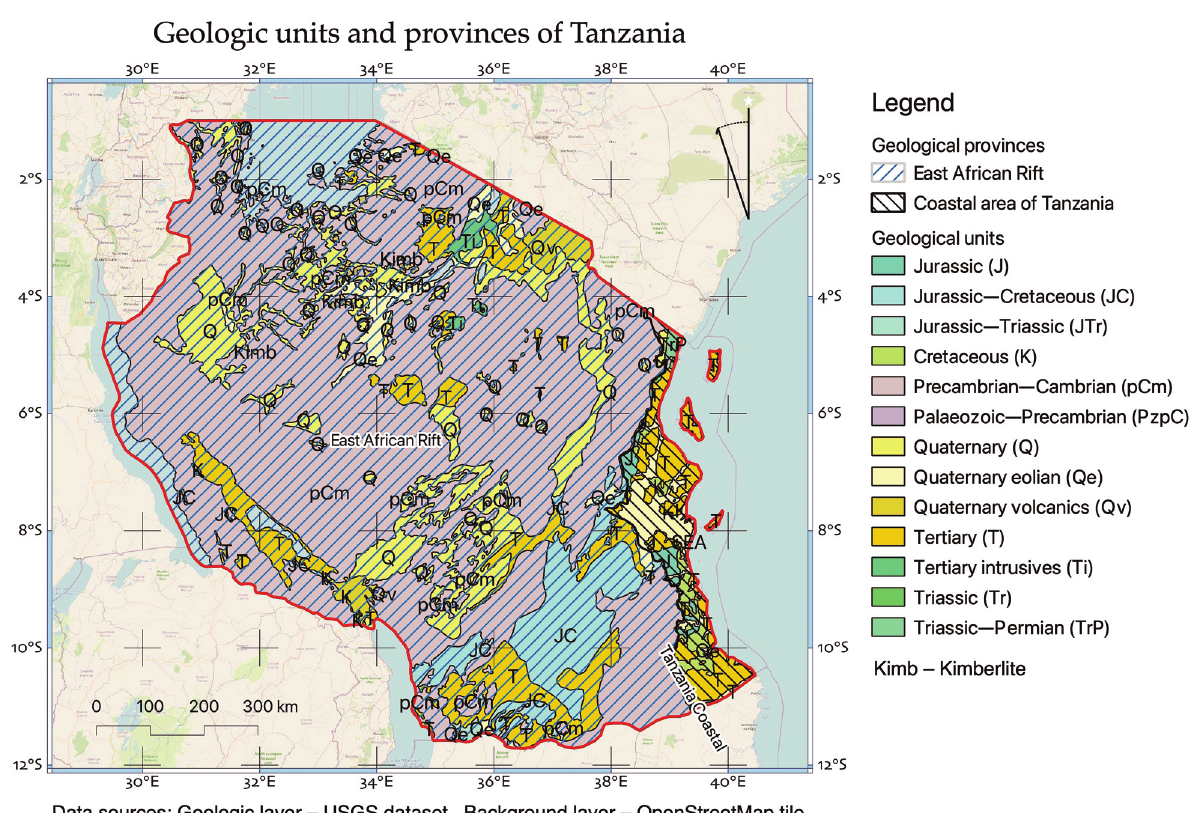
Fig. 2. Geological units and provinces in Tanzania. Data source: United States Geological Survey (USGS) (Persits et al. 1997) and OpenStreetMap (OpenStreetMap contributors). Map source: elaborated by the